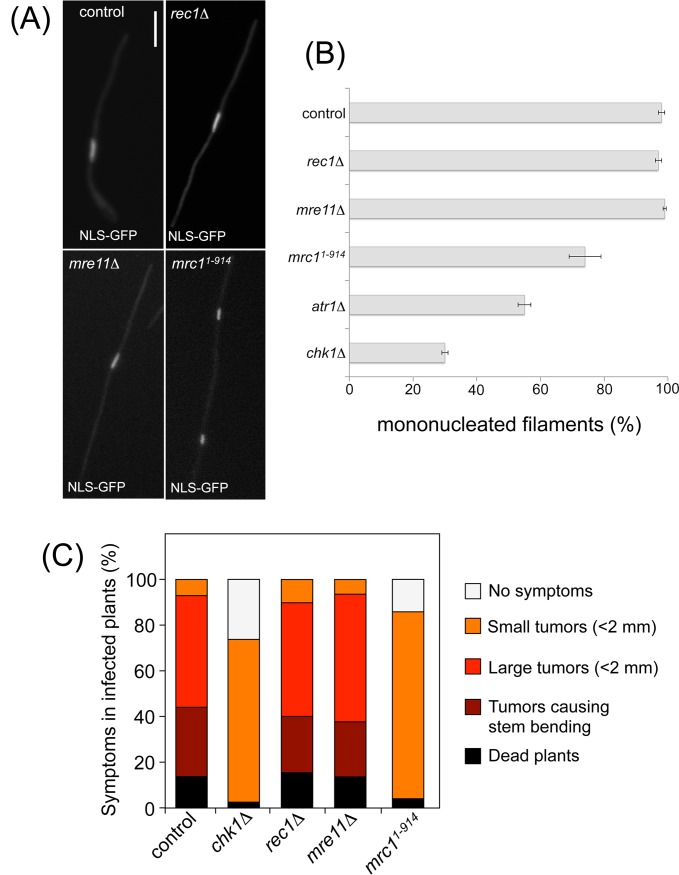
MRN and 9-1-1 complexes are dispensable for virulence and b-dependent
cell cycle arrest.(A) Cell images of control (UMP112) and derived strains carrying the
indicated mutations incubated for 8 h in inducing conditions (MMD).
Strains carried an NLS-GFP fusion under control of the b-dependent
dik6 promoter to detect the nucleus. Bar: 20
μm. (B) AB33-derived strains carrying the
P
dik6:NLS-GFP
transgene and carrying the indicated mutations were incubated in
inducing conditions (MMD) for 8 hours. Filaments were sorted as carrying
1 or 2 and more nuclei. The graph shows the result from two independent
experiments, counting more than 50 filaments each. Means and SDs are
shown. (C) Disease symptoms caused by the indicated crosses were scored
14 days after infection of 7-day-old maize seedlings. Symptoms were
grouped into color-coded categories depicted on the right side of graph.
Two independent experiments were carried out and the average values are
expressed as percentage of the total number of infected plants (n:
> 50 plants).